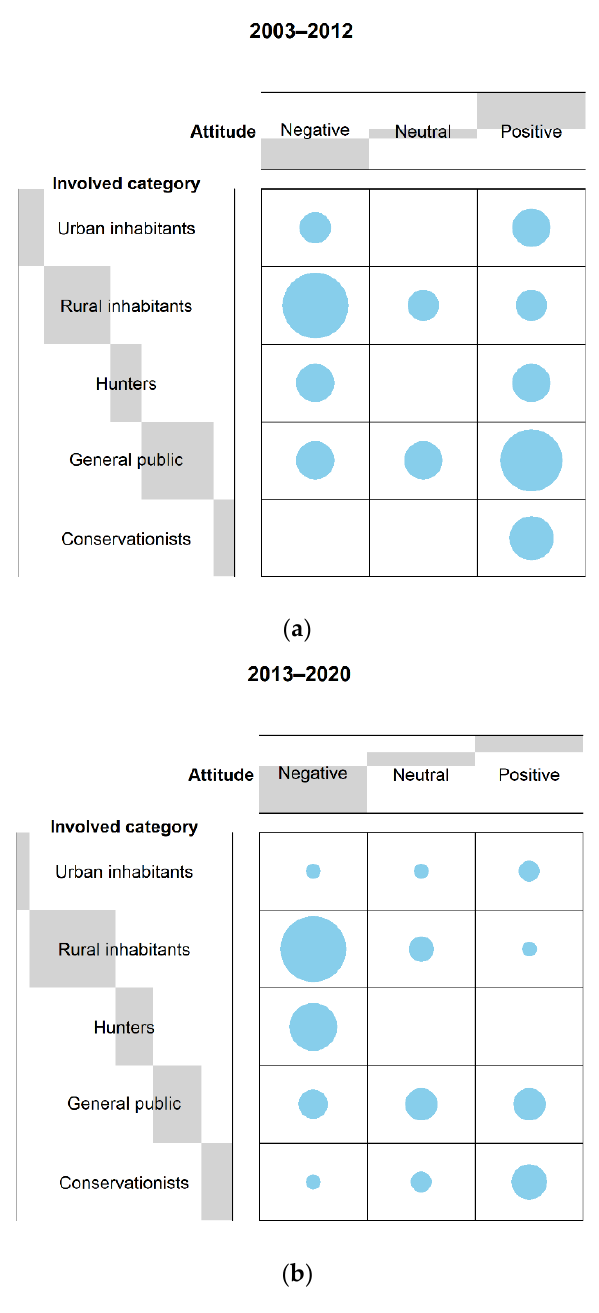
Figure 4. ( a ). Contingency table showing the distribution frequency regarding the attitude towards carnivores of each category involved in the first period (2003–2012). The size of the grey bars de- pends on the number of responses obtained by each stakeholder category for each attitude (refer to Figure 3 caption for a more detailed explanation). For the reference list divided by periods, refer to